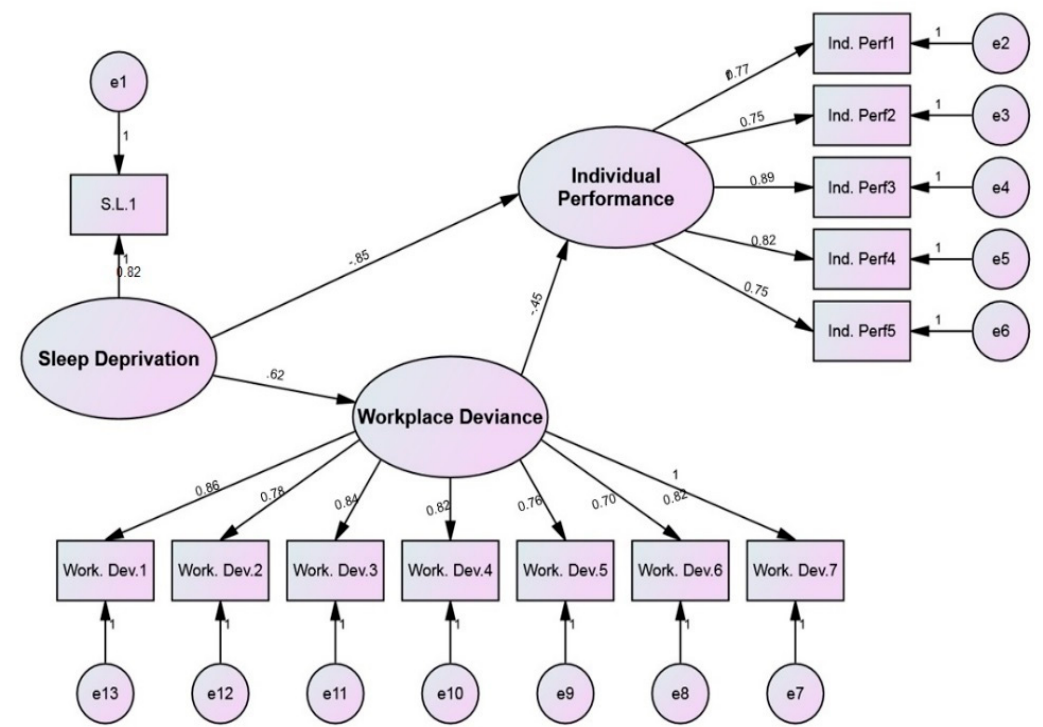
Figure 1. Measurement model.